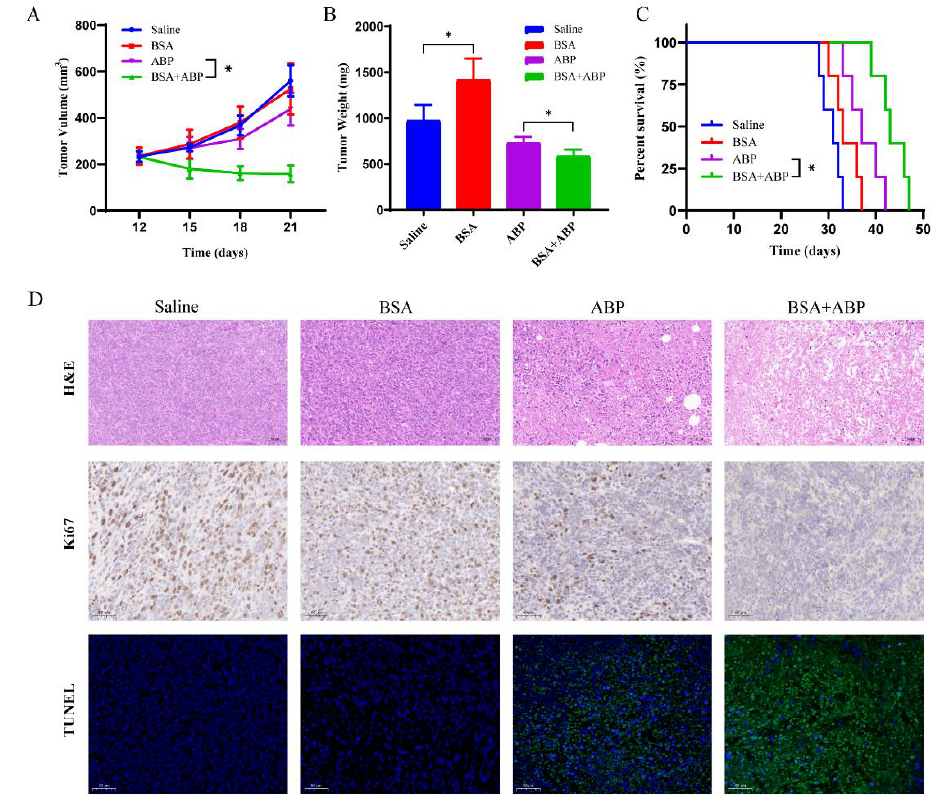
Figure 4. Application of saturated dose of BSA nanoparticles in antitumor efficacy. ( A ) Tumor volumes, ( B ) tumor weights, and ( C ) survival curves of mice following the various treatments. ( D ) Hematoxylin and eosin (H&E), Ki67, and TUNEL staining of tumor tissues from each group. * p < 0.05 between groups.